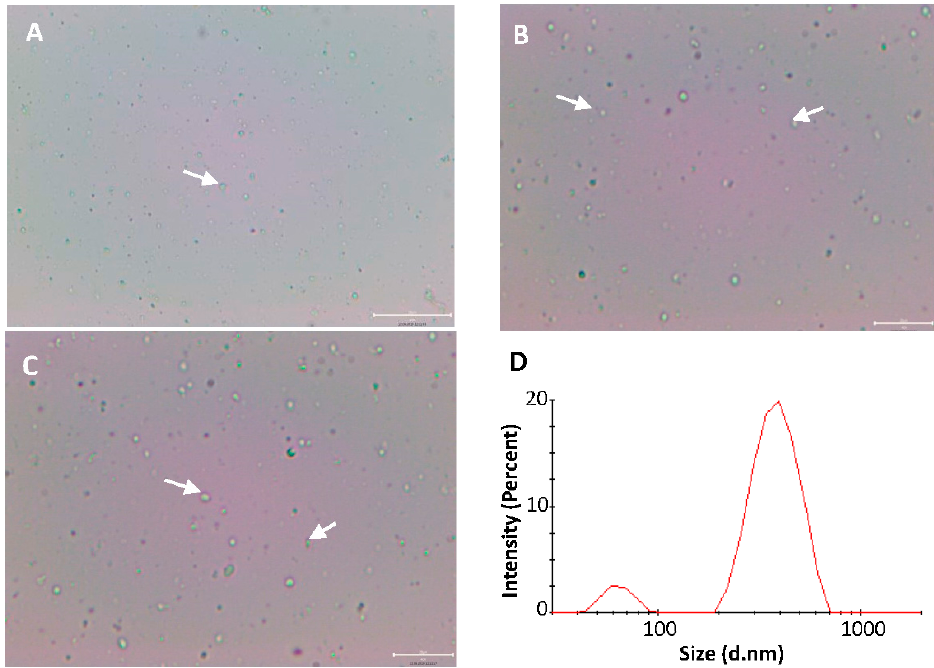
Figure 5. The optical microscopy images ( A – C ) and the PCS size and size distribution ( D ) of the self-assembled liposomes in purified water. The liposomes consisting of soybean PC and HAE are spontaneously dispersed from the electrospun amphiphilic nanofibrous template. Due to the limited magnification (50×) of an optical microscope, only the liposomes composed of large vesicles can be seen. Some selected clusters of liposomes are indicated by white arrows. Scale bar 20 µm with 20× ( A ), and 40× ( B , C ).